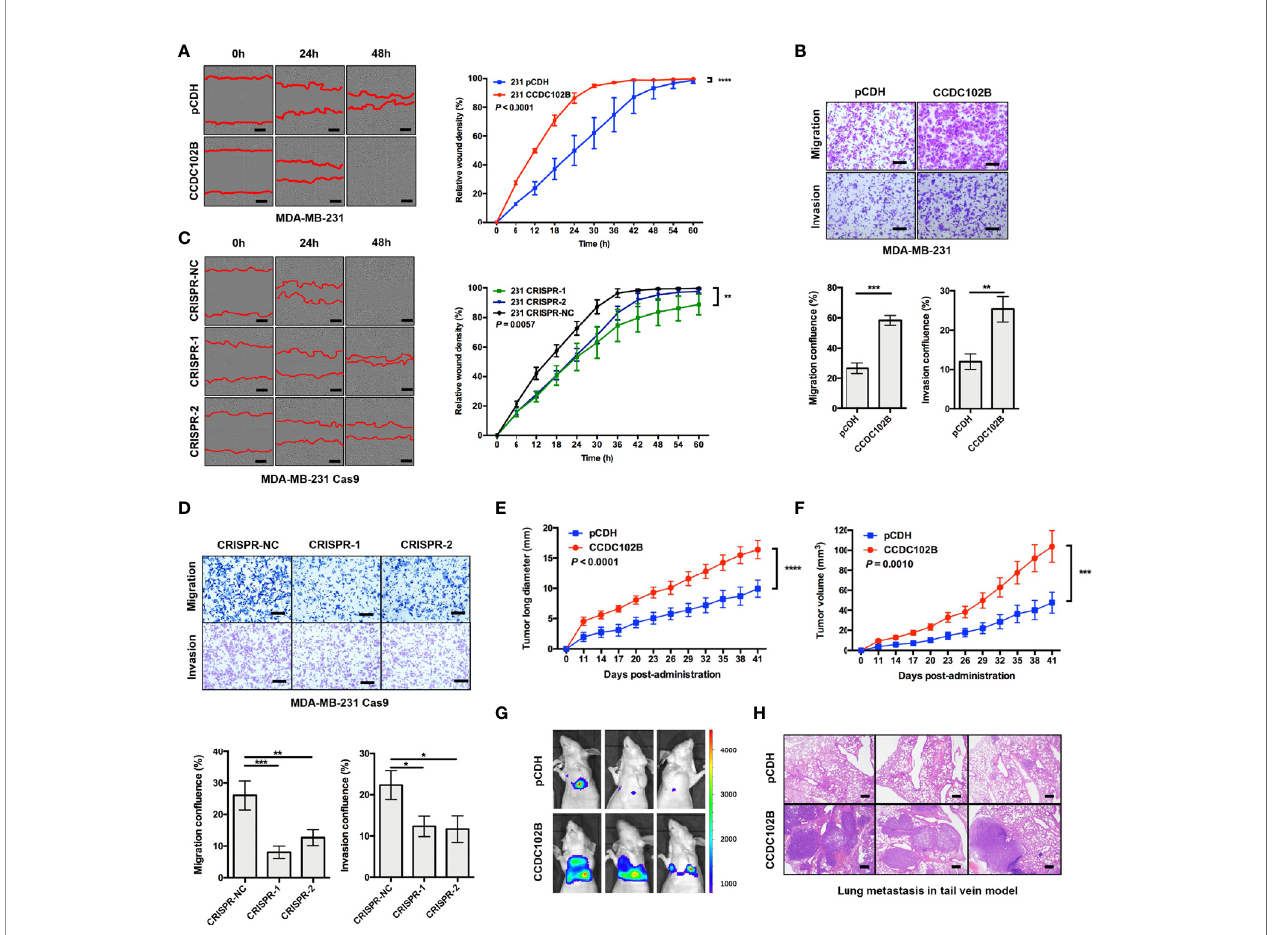
FIGURE 3 | CCDC102B promotes breast cancer metastasis. (A, B) Wound healing assay and Transwell assay in MDA-MB-231 cells. CCDC102B overexpressed cells and the corresponding control cells were used. Representative photos and quantitative analysis were shown. Relative wound density was determined by IncuCyte. Con fl uence of Transwell was analyzed by ImageJ. n=3, biological replicates. Scale bars: 100 m m. (C, D) Wound healing assay and Transwell assay in MDA-MB-231 Cas9 cells. CCDC102B KO cells by CRISPR system and the corresponding control cells were used. Representative photos and quantitative analysis were shown. Relative wound density was determined by IncuCyte. Con fl uence of Transwell was analyzed by Image J. n=3, biological replicates. Scale bars: 100 m m. (E, F) Tumor long diameter and tumor volume were measured in orthotopic xenograft breast cancer model with overexpressed CCDC102B cells and the corresponding control cells. (Unpaired t test was performed on the day 41, n=12 of each group) (G) BLI of three representative mice in each group 6 weeks after injection with transduced cells in tail vein model. (n=6 of each group) (H) Representative images of H&E staining of lung metastasis in each group 6 weeks after injection with transduced cells in tail vein model. (n=6 of each group) Scale bars: 500 m m. *P ≤ 0.05; **P ≤ 0.01; ***P ≤ 0.001; ****P ≤